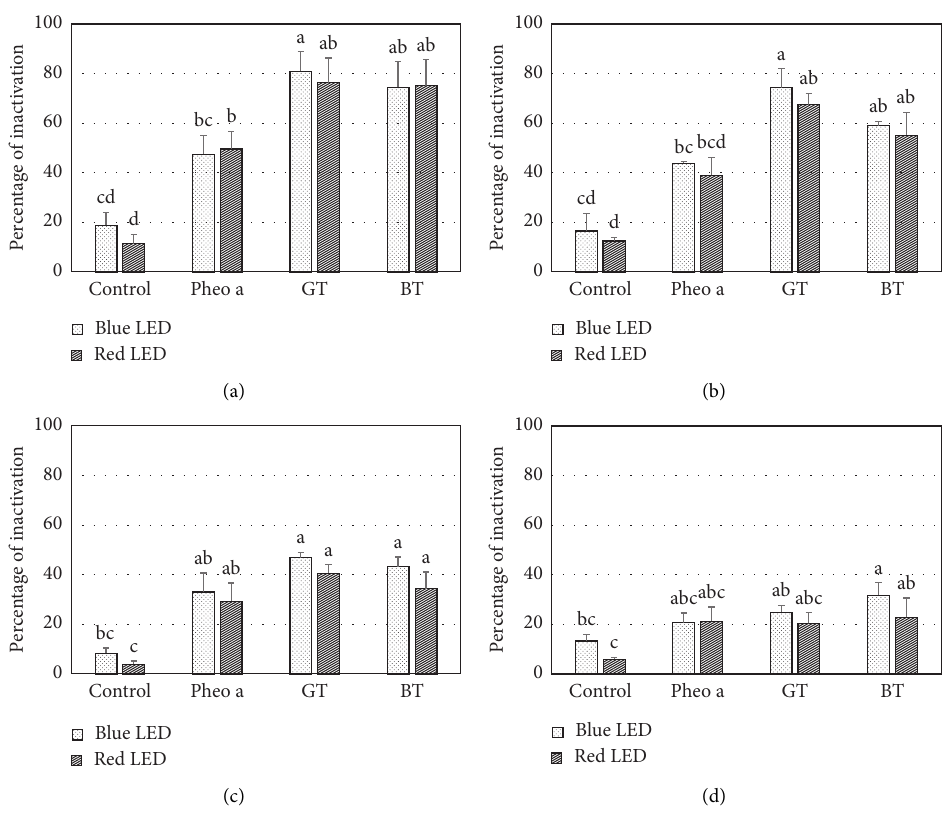
Figure 7: Percentages of inactivation observed in four species of bacteria: (a) Listeria monocytogenes , (b) Staphylococcus aureus , (c) Escherichia coli , and (d) Salmonella typhi , by using the treatment with various sensitizers and under illumination of blue and red LEDs for 30min. The types of applied sensitizers were as follows: sterile 1% Tween 80 as the medium for pigments dispersion (control), pheophytin a (Pheo a), and pigments recovered from the dregs of green tea (GT) and black tea (BT). The error bars represent standard error of the mean for three repetitions in each treatment. The upper letters indicate the significant differences ( p < 0.05) among treatments according to pairwise Fisher’s test.